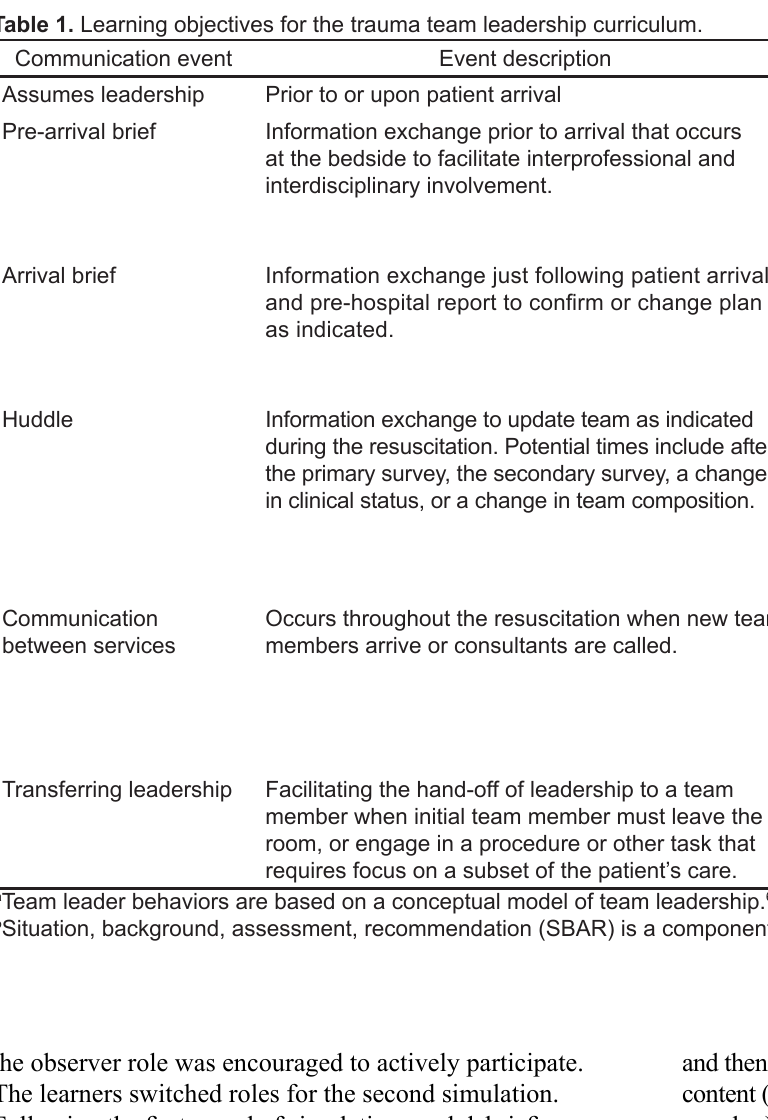
the observer role was encouraged to actively